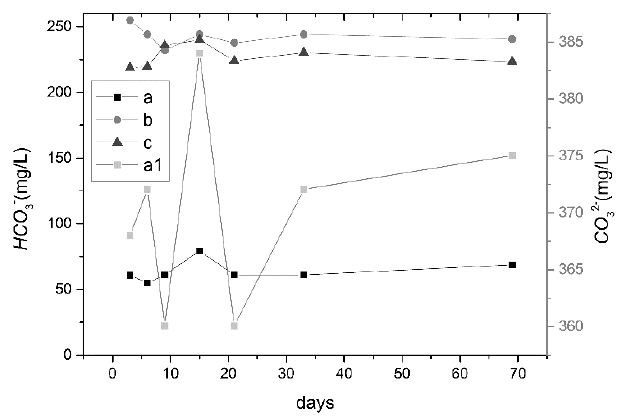
Figure 4. Concentration curves of CO 32 − and HCO 3 − contents in sample liquids (a, b, and c, respectively, represent HCO 3 − content of liquids with oil shale heated to 300 °C, oil shale heated to 500 °C, and unheated oil shale; a1 represents the CO 32 − content of liquids with oil shale heated to 300 °C).